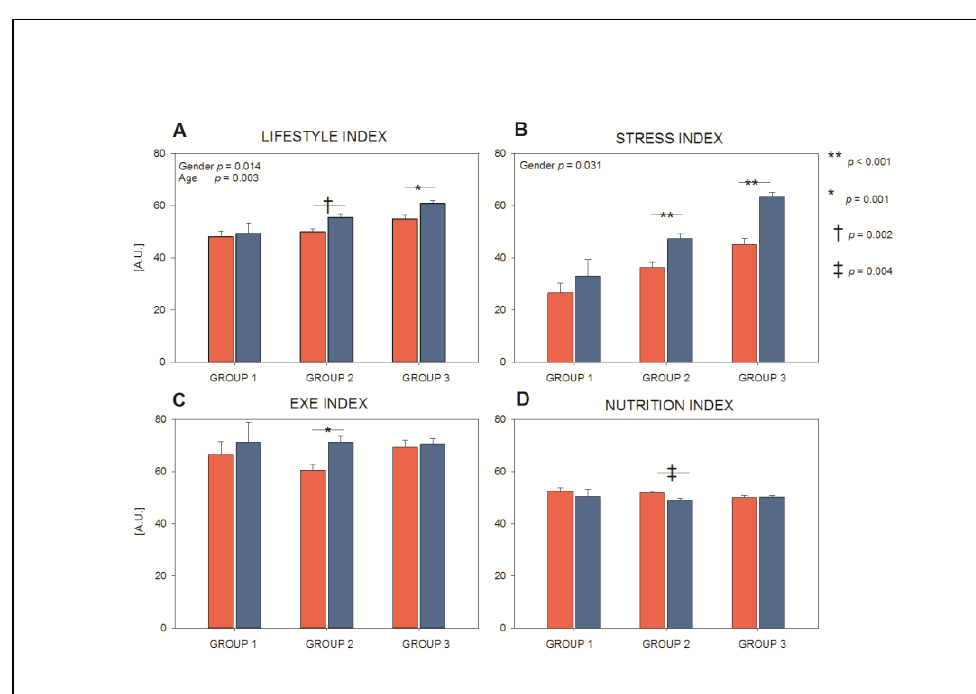
Figure 1. Lifestyle (panel ( A )), stress (panel ( B )), exercise (panel ( C )), and nutrition (panel ( D )) indexes in the three age groups in women (red bars) and men (blue bars) employees. Note that the lifestyle index (which simultaneously considers the contribution of stress, nutrition, and exercise habits) best depicts the differences due to age and gender and that the youngest (both men and women) employees presented the worst lifestyle index, particularly in its stress component. EXE = exercise.